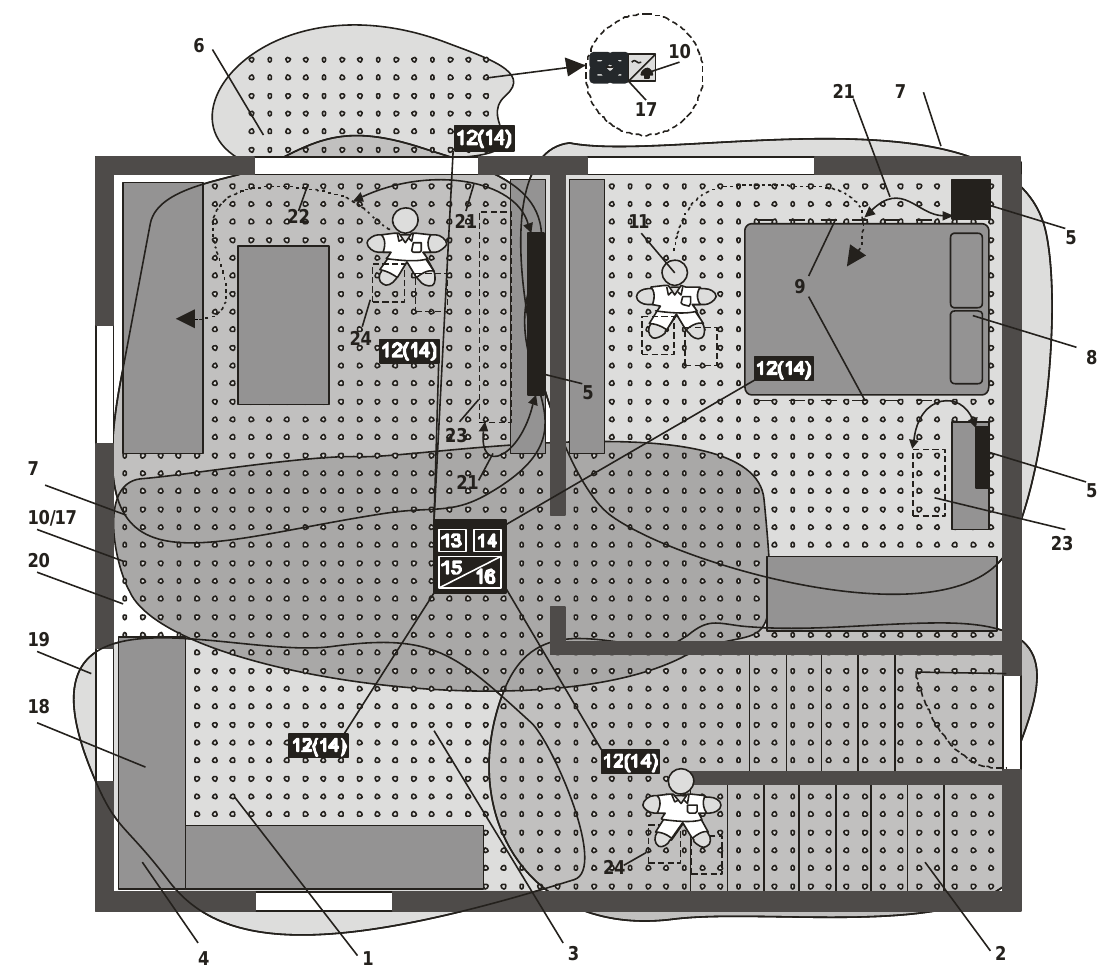
Figure 32. Idea of the active floor: 1 — operating area; 2 — stairs; 3 — room; 4 — building equipment